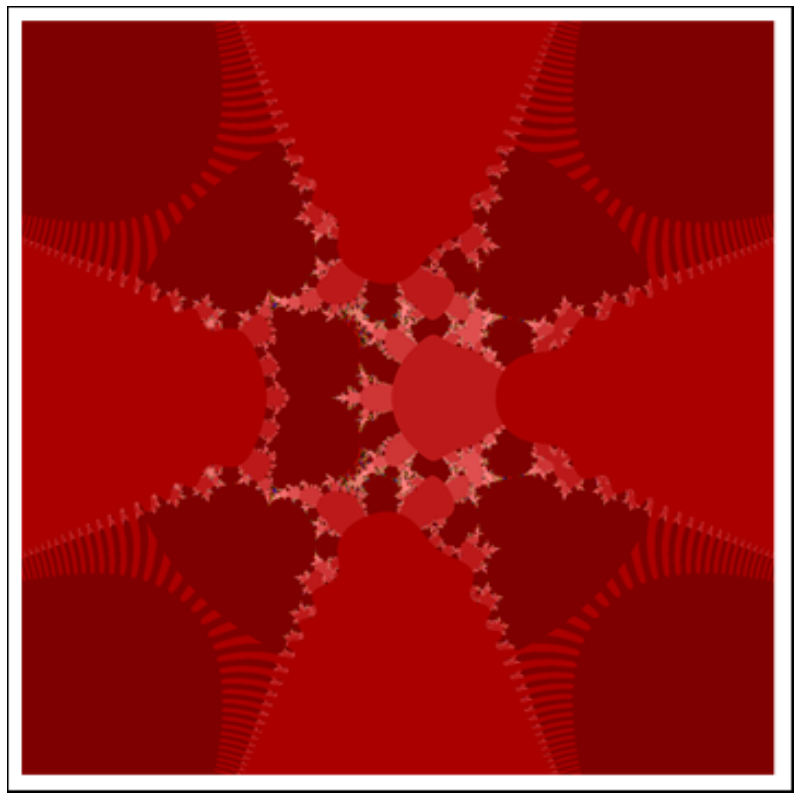
Figure 33. M-set for τ ( z ) = e z 2 + c via DKIS. The image execution time is 98.46